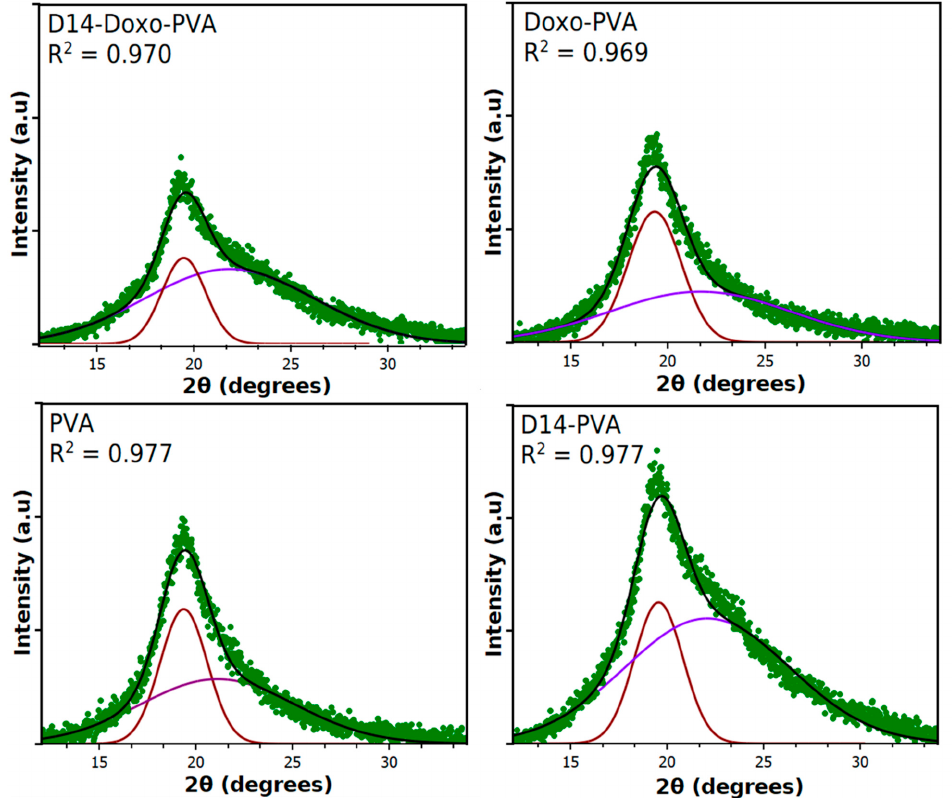
Figure A4. Deconvolution of the PVA majority peak into amorphous and crystallinity peaks in order to calculate the % crystallinity. Only two peaks were used for deconvolution in order to represent an average value of the whole hydrogel.